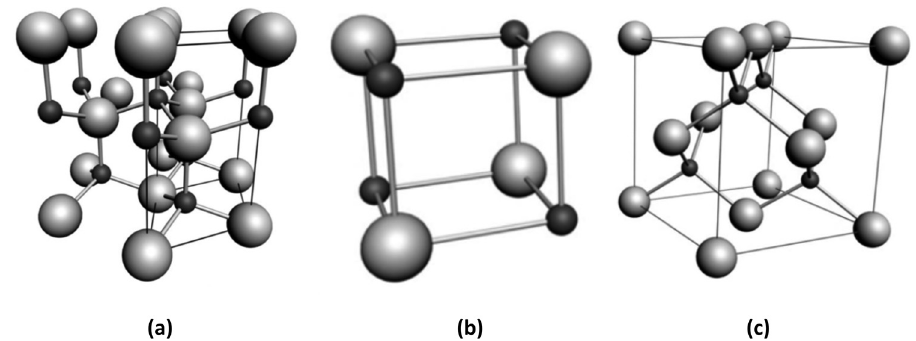
Figure 4: ( a ) The hexagonal wurtzite structure of ZnO, ( b ) the rock - salt, and ( c ) zinc blende phases of ZnO. O atoms are shown as white spheres, and Zn atoms are shown as black spheres. Only one - unit cell is illustrated for clarity. Reproduced with permission from Elsevier [ 119 ] .